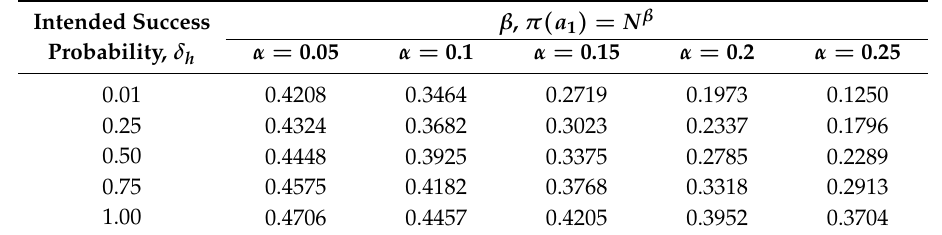
Table 2. Comparison in Number of Candidates of a 1 In Terms of Logarithm to Base N with Respect to δ h and α